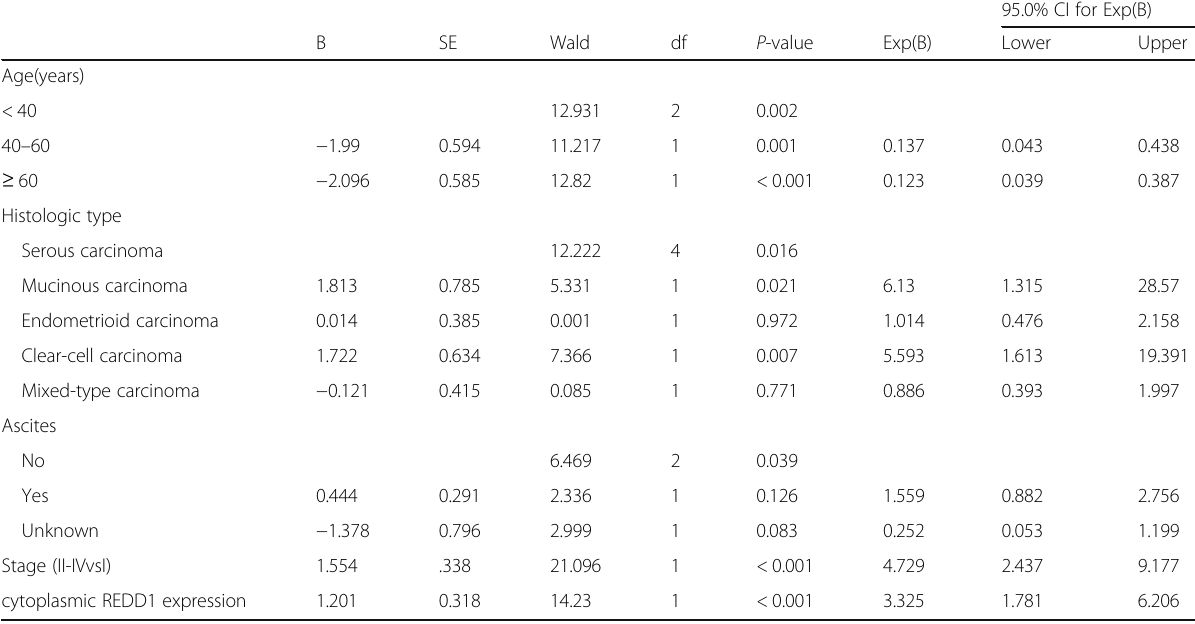
Table 6 The multivariate Cox proportional- hazards regression for OS